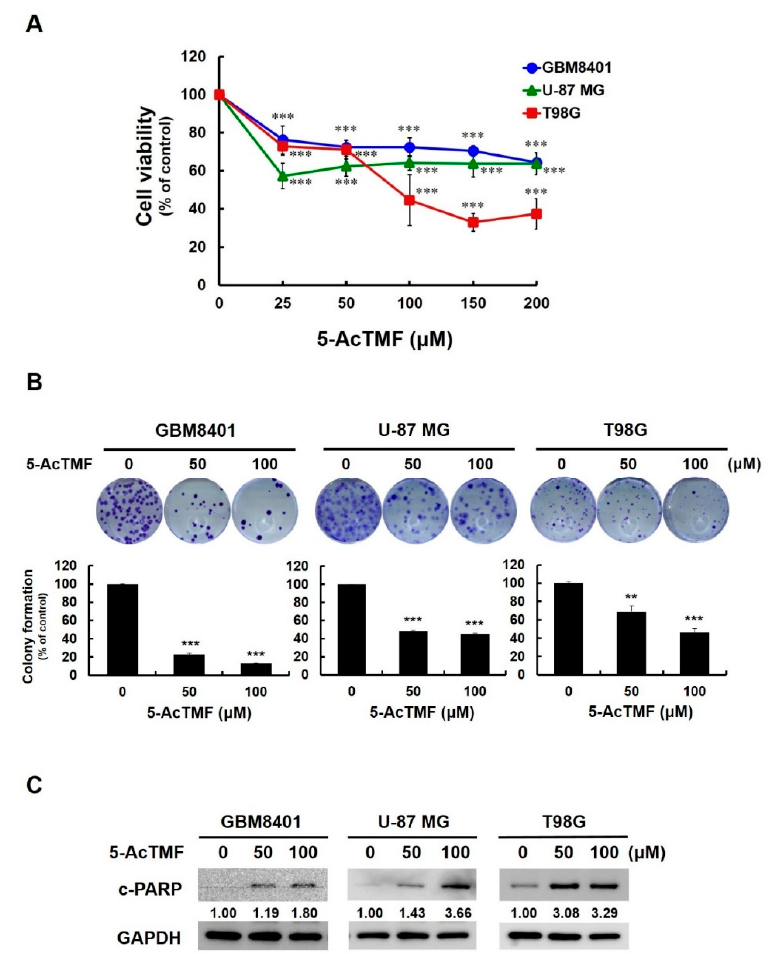
Figure 1. Inhibitory effect of 5-AcTMF on cell growth and survival of multiple human GBM cell lines. ( A ) Cytotoxic effect of 5-AcTMF on GBM cells. Human GBM cell lines GBM8401, U-87 MG, and T98G